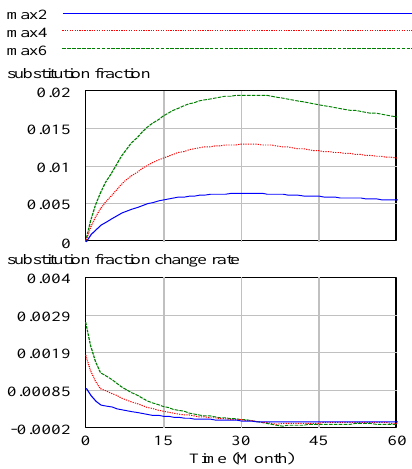
Figure 9. Substitution fraction and change rate. (max2, max4, max6 represent the maximum substitution fraction of the variable is equal to 0.2, 0.4, and 0.6).